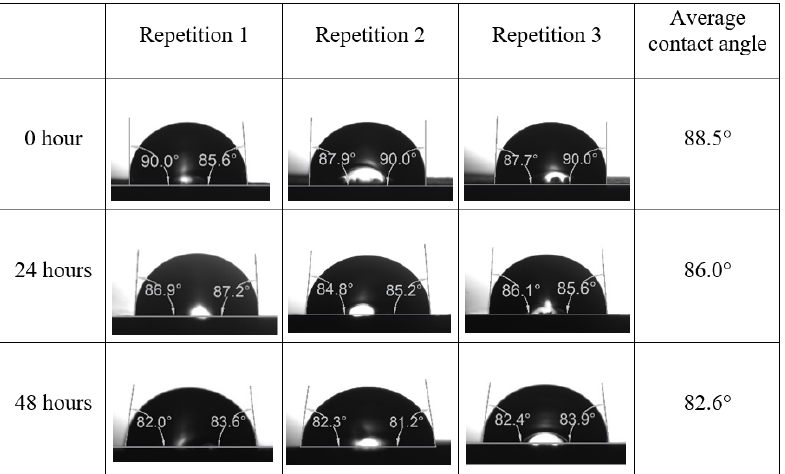
Figure A14. Dynamic Contact Angle Measurement Results for 75% MgCl 2 + 25% CaCl 2 (3500